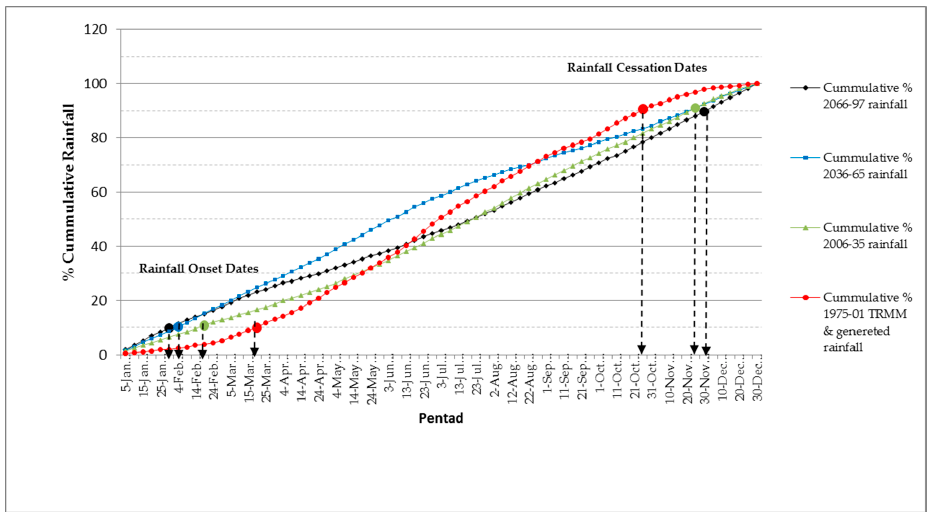
Figure 4. Agago Future Mean Rainfall Onset and Cessation (TRMM, weather generated Rainfall